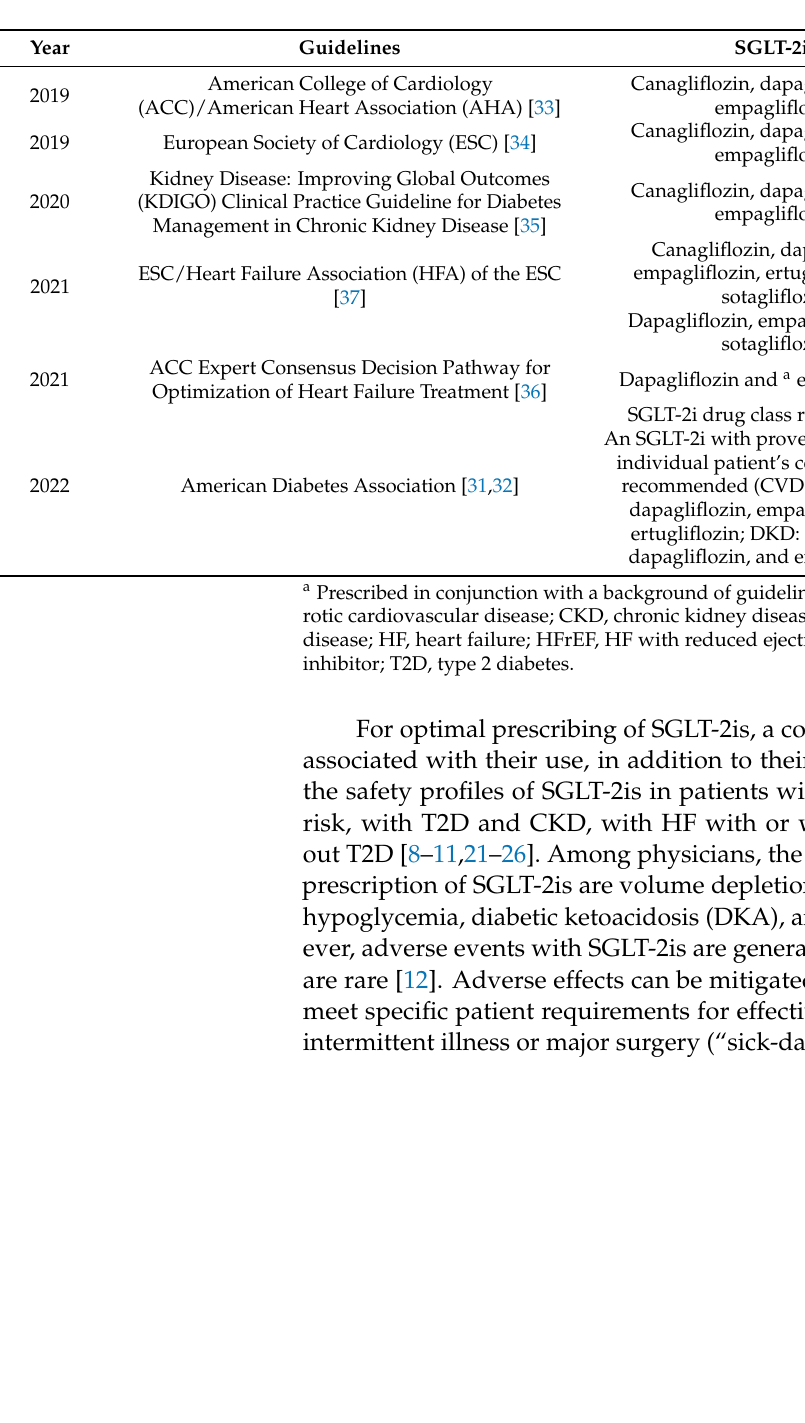
Table 2. Guidelines for the use of